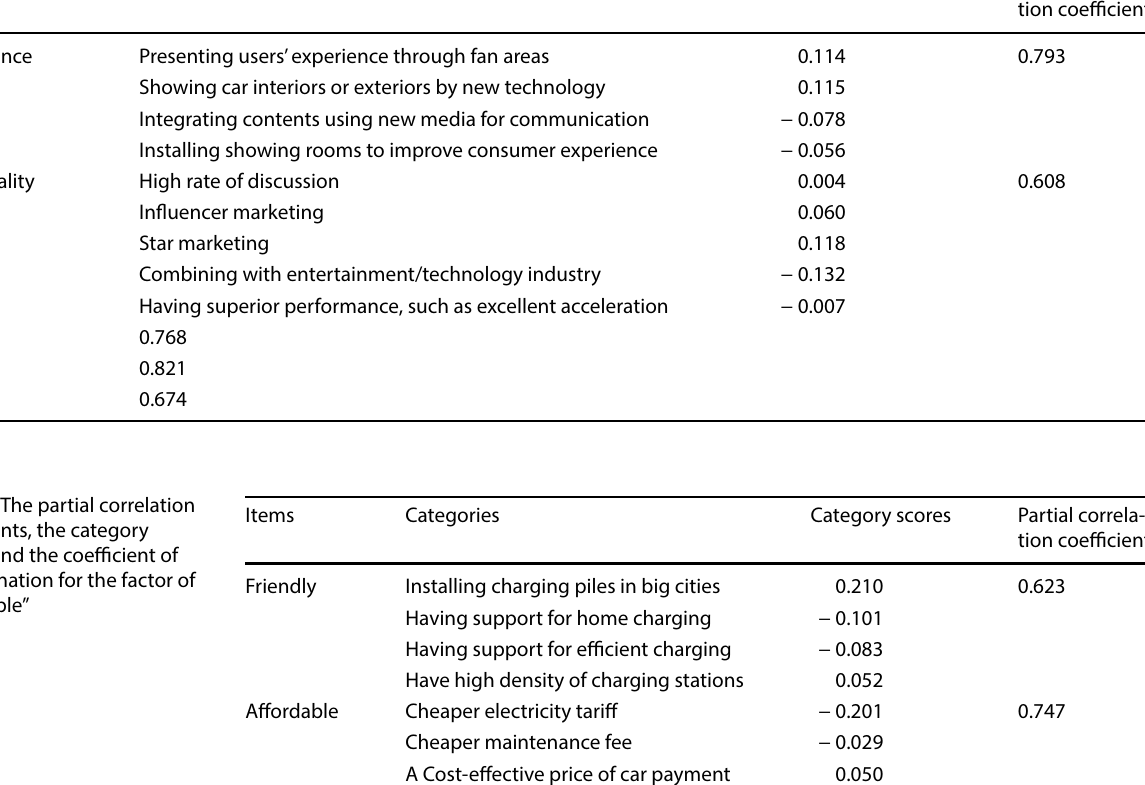
Table 4 The partial correlation coefficients, the category scores, and the coefficient of determination for the factor of “scenario-based” Items